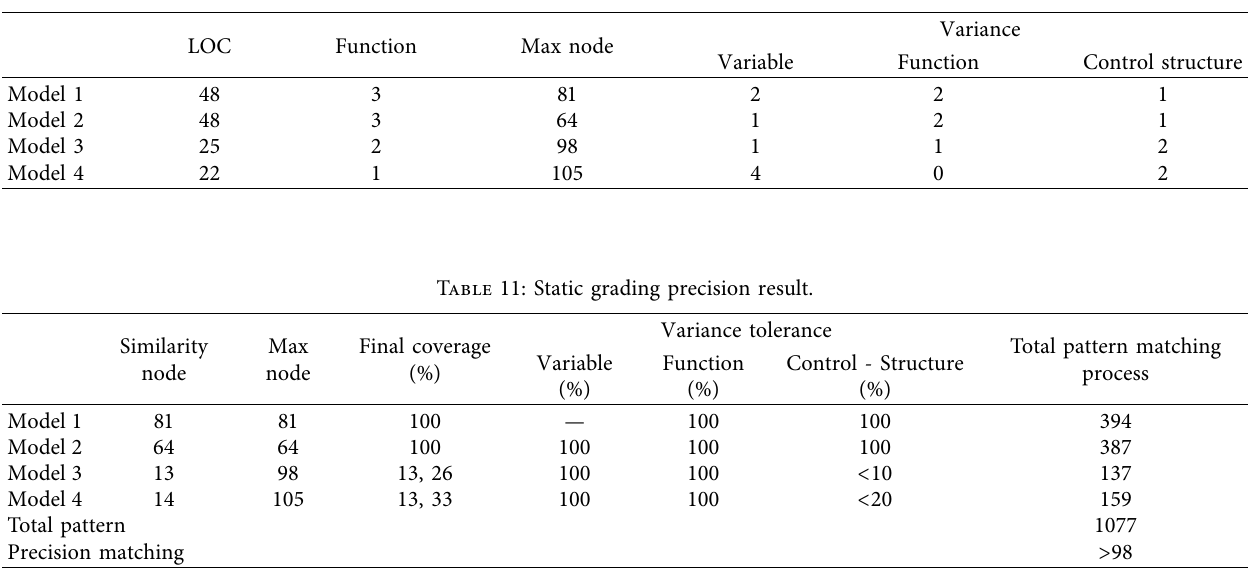
Table 10: Model program condition.